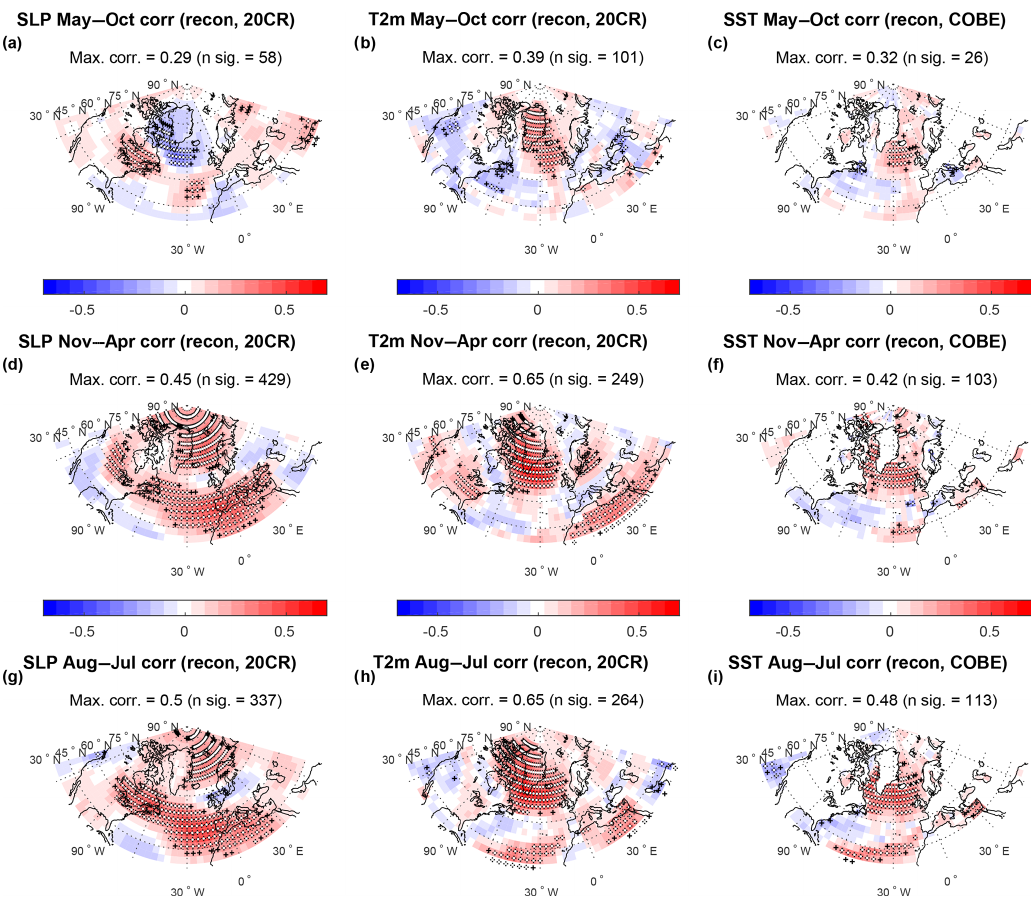
Figure 4. (a–c) Correlation between reconstructed (eight ice cores) and reanalysis SLP, T2m and COBE SST for sum50 (May–October). The reanalysis data have been interpolated to the model grid (3 . 75 ◦ × 3 . 75 ◦ ). Black markers indicate p < 0 . 05, and white markers indicate p < 0 . 025. Also indicated is the maximum correlation (Max. corr.) and the number of significantly correlated grid points ( n sig.) ( p < 0 . 05). Panels (d) – (f) are the same as (a) – (c) but for win50 (November–April). Panels (g) – (i) are the same as (a) – (c) but for the winter-centered annual mean (win100, August–July). Figure S8 shows corresponding figures for the reconstructions using 19 ice